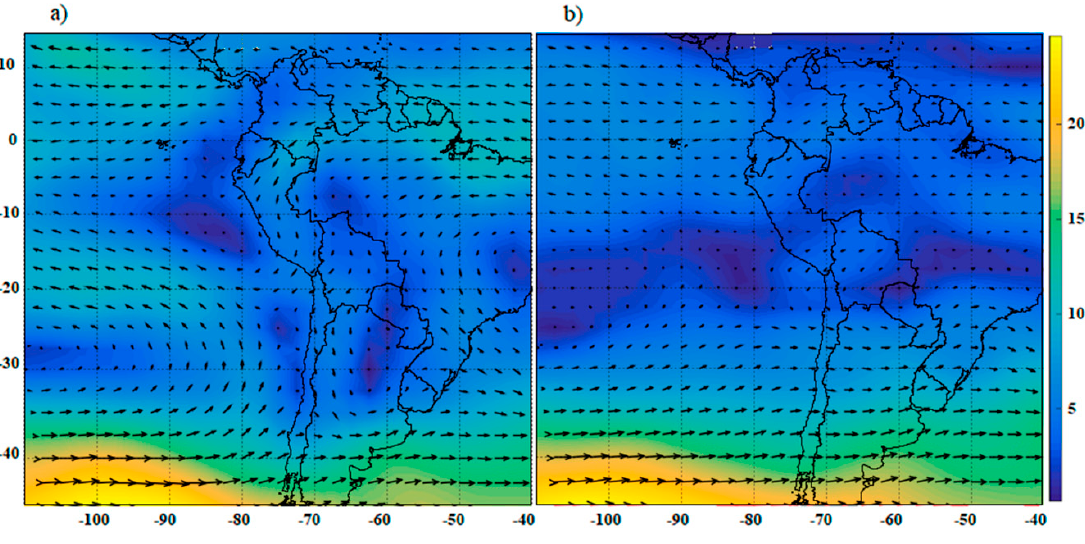
Figure 7. Geopotential height (m) composite charts for 500 hPa (top) and 700 hPa (bottom) averaged over the rainy seasons of 1981–2017 ( a , d ); the 40 extreme rainfall event cases ( b , e ) and their difference ( c , f ) to highlight deviations from the rainy season climatology.